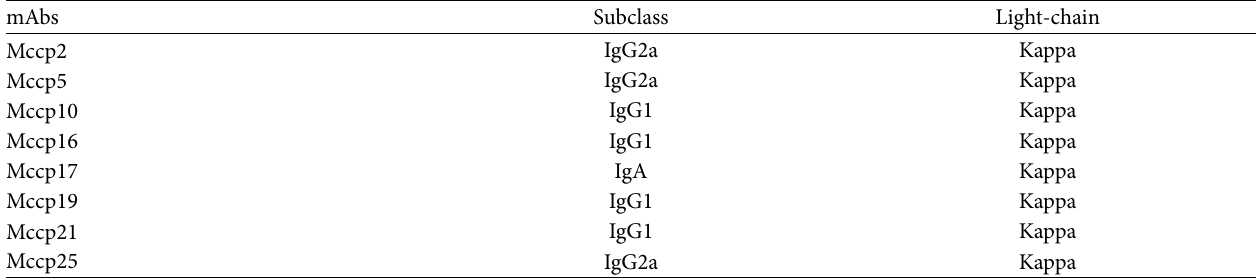
Figure 3: Reaction of Mccp mAbs on Mccp antigen coated in microplate. Table 1: Classification of generated Mccp mAbs by mouse isotyping method.